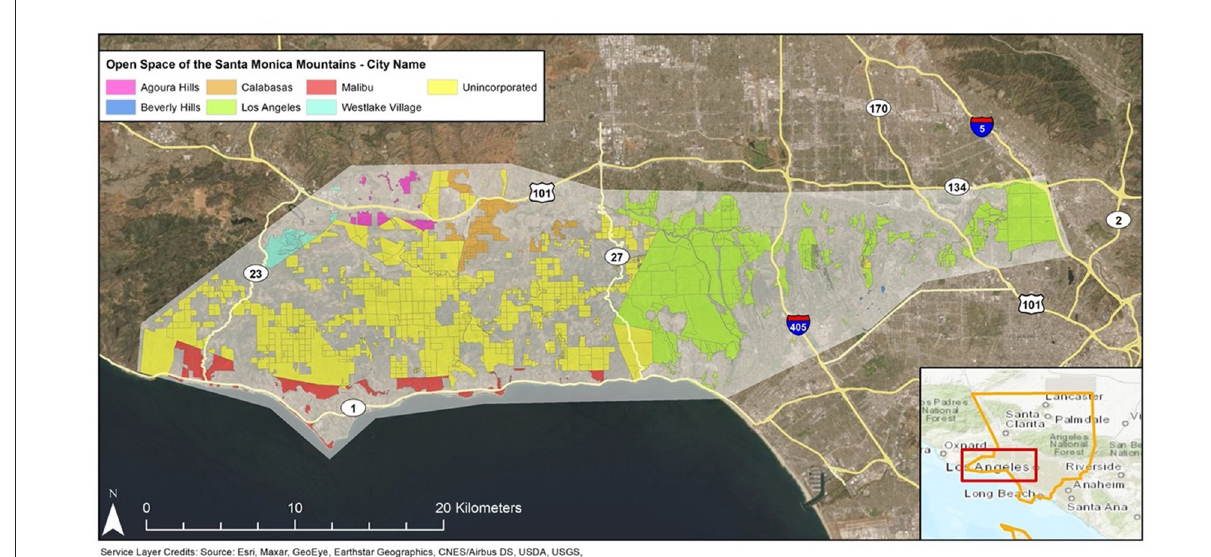
FIGURE1 Map of protected open space of Santa Monica Mountains within Los Angeles County, by city (shading added to improve visibility). Griffith Park is the large green area at the far east, and Topanga State Park dominates the green area in the center (both within the city of Los Angeles). The surrounding cities of West Hollywood, Burbank, Glendale, Santa Monica, and Hidden Hills contain small portions of the Santa Monica Mountains topographically, but these areas are largely urbanized and do not contain protected open space, so are not reflected on the